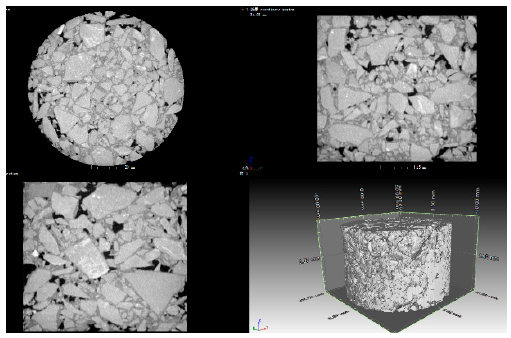
Figure 1. 3D vision of asphalt mixture sample.